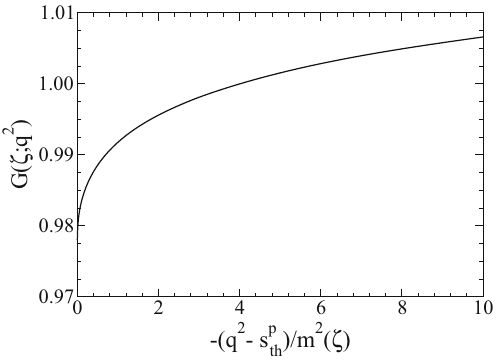
Fig. 6 The running charge G (ζ ; q 2 ) , Eq. (88), below the threshold vs = 4 m 2 (ζ) q 2 , with s p th